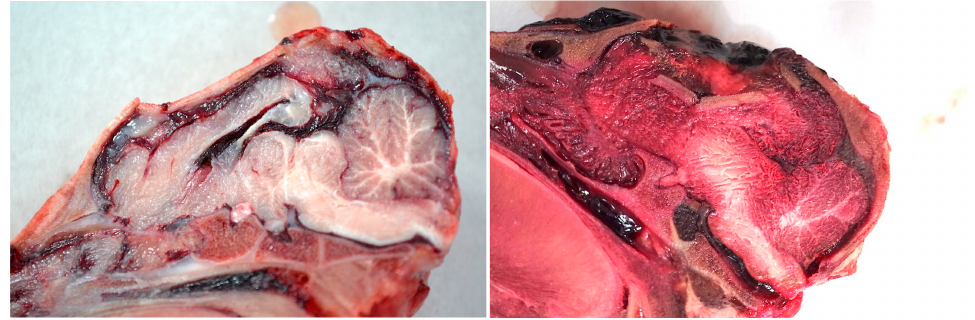
Figure 12. Examples of post-shot trauma; medial sagittal section demonstrating bone fracture displacement and macroscopic brain damage (1 grain